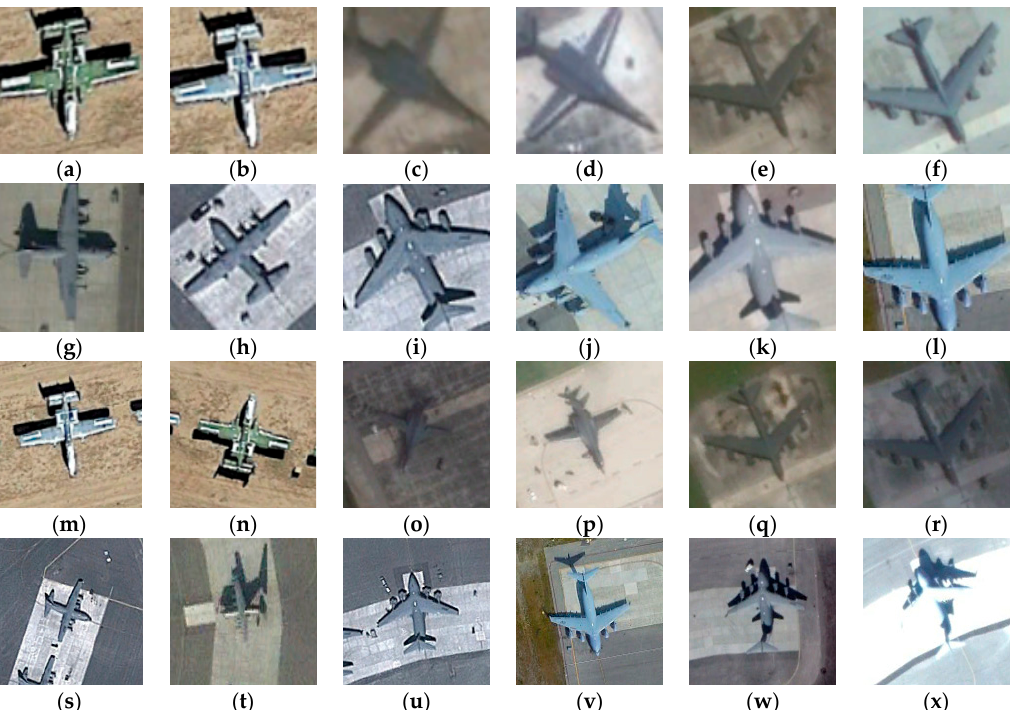
Figure 6. Airplanes slices with different types from two slices sets of dataset 1. ( a – l ) are from slices set 1 of dataset 1, and ( m – x ) are from slices set 2 of dataset 1.